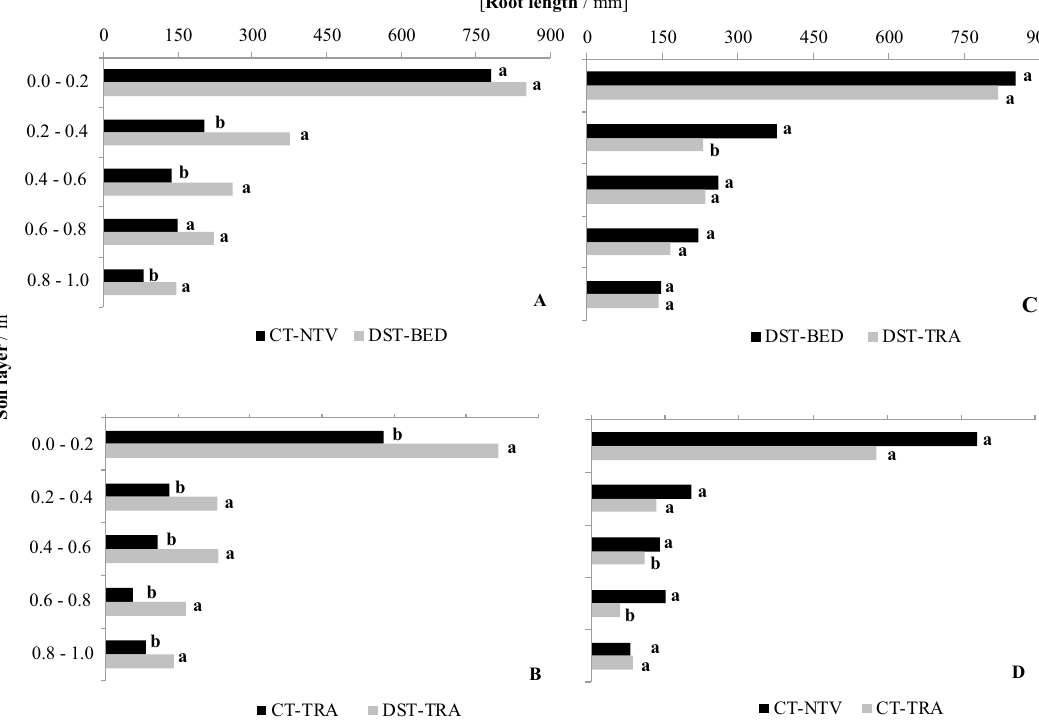
Figure 8. Root length for: ( A ) conventional tillage no traffic lane (CT-NTV) and deep strip tillage bed with no traffic (DST-BED), ( B ) conventional tillage traffic lane (CT-TRA) and deep strip tillage traffic lane (DST-TRA), ( C ) DST-BED and DTS-TRA, and ( D ) CT-NTV and CT-TRA. Different lower case letters indicate significant differences between treatments with the p ≤ 0.15 confidence intervals of the log-transformed